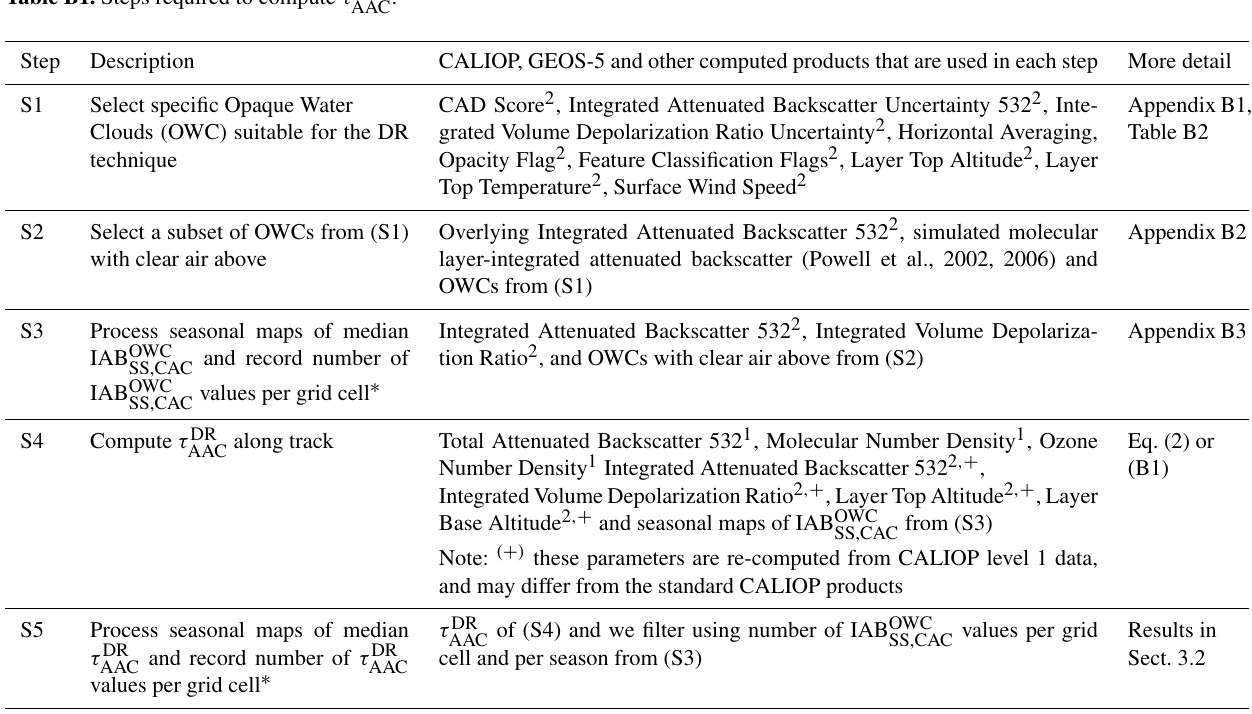
Table B1. Steps required to compute τ DR